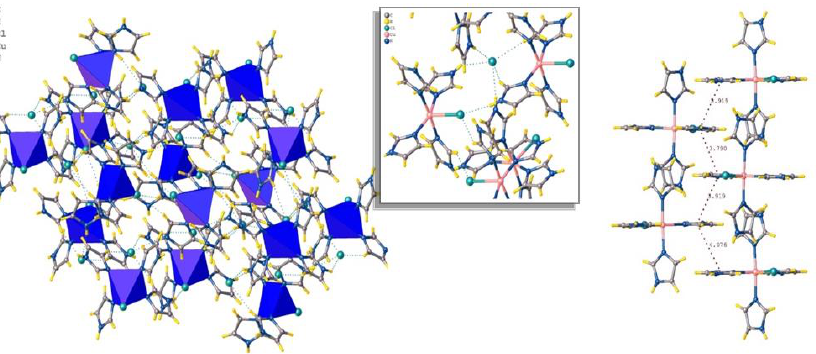
Figure 2. A continuous 3D of copper hybrid organic–inorganic ligand frameworks showing the in- intermolecular interactions of hydrogen bonding and π · · · π stacking. termolecular interactions of hydrogen bonding and π ⋯ π stacking.